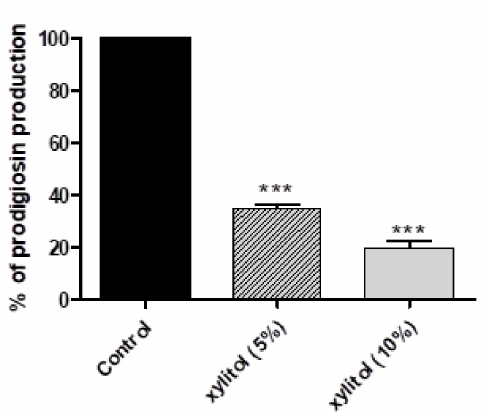
Figure 2. Inhibition of prodigiosin production by Serratia marcescens by xylitol. Prodigiosin pigment was extracted from xylitol-treated and untreated cells by acidified ethanol. The test was performed in triplicate and the absorbance was measured at 534 nm. Xylitol significantly reduced prodigiosin production. The data shown are the means ± standard errors. One-way ANOVA test followed by Dunnett’s Multiple Comparison test was used for statistical analysis. ***: p ≤ 0.001.